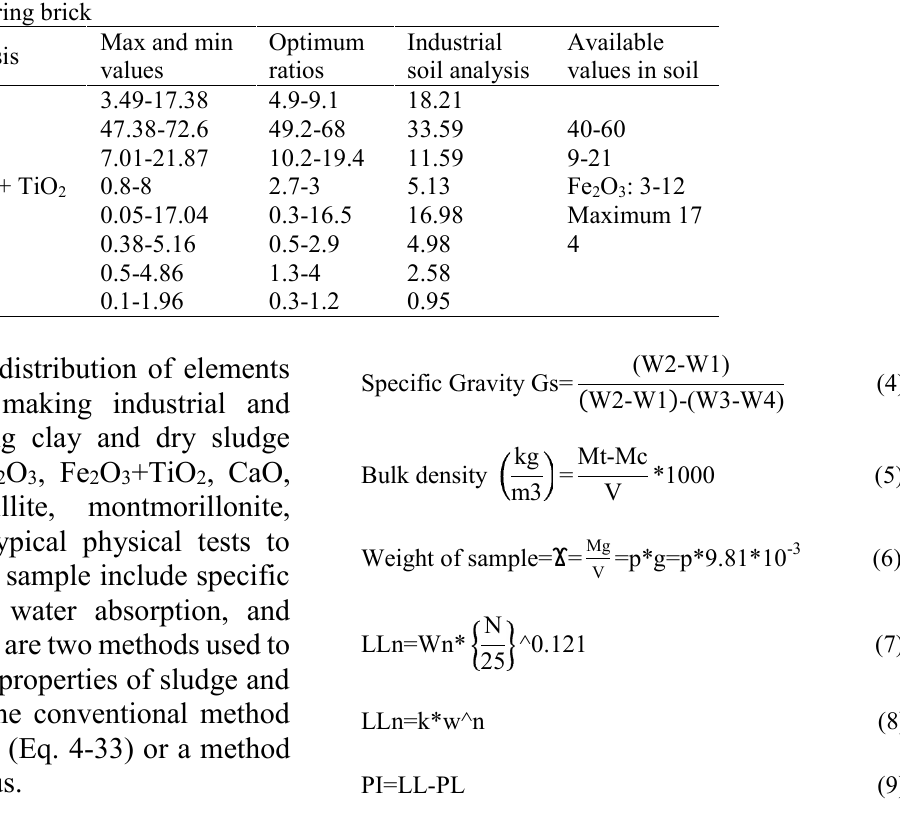
Table 3. Chemical analysis of allowable values (%) for making industrial